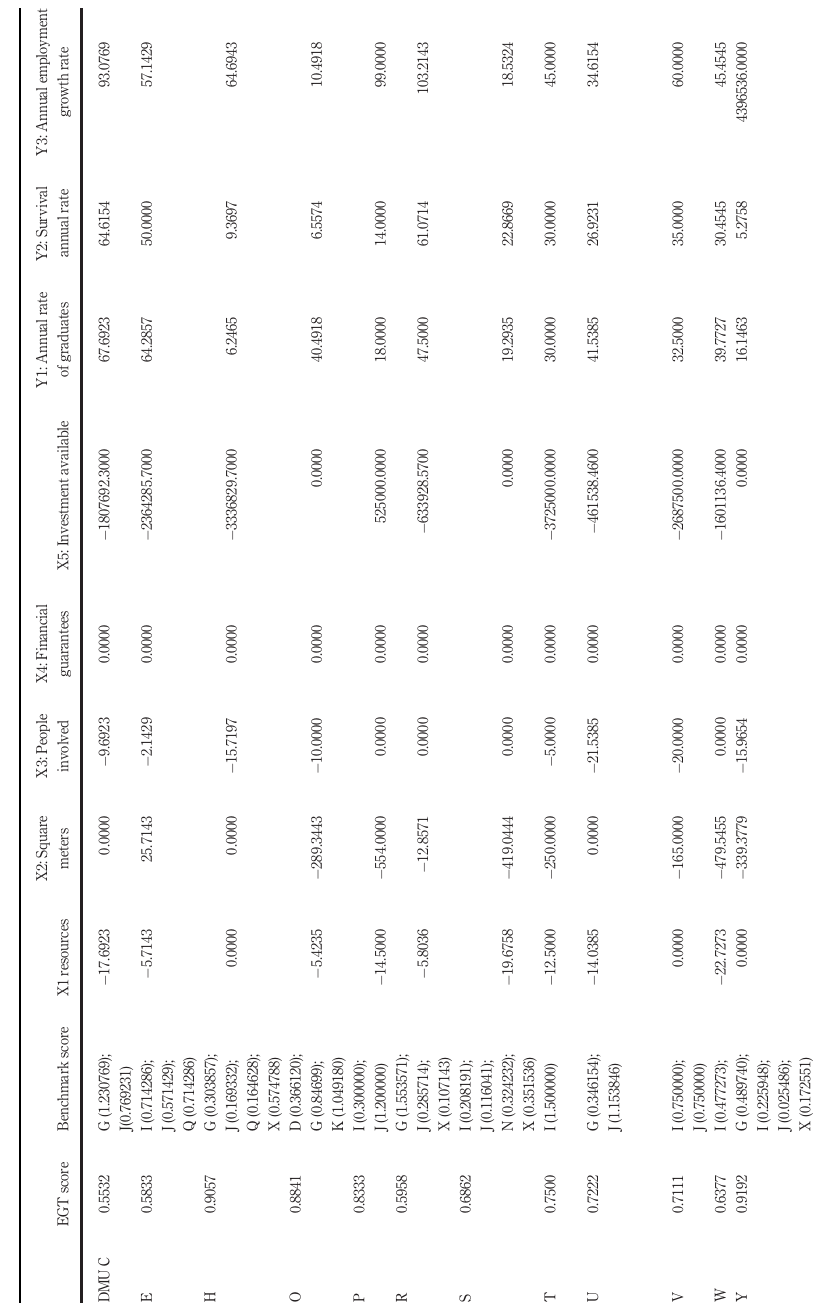
Table 8. Benchmarking analysis